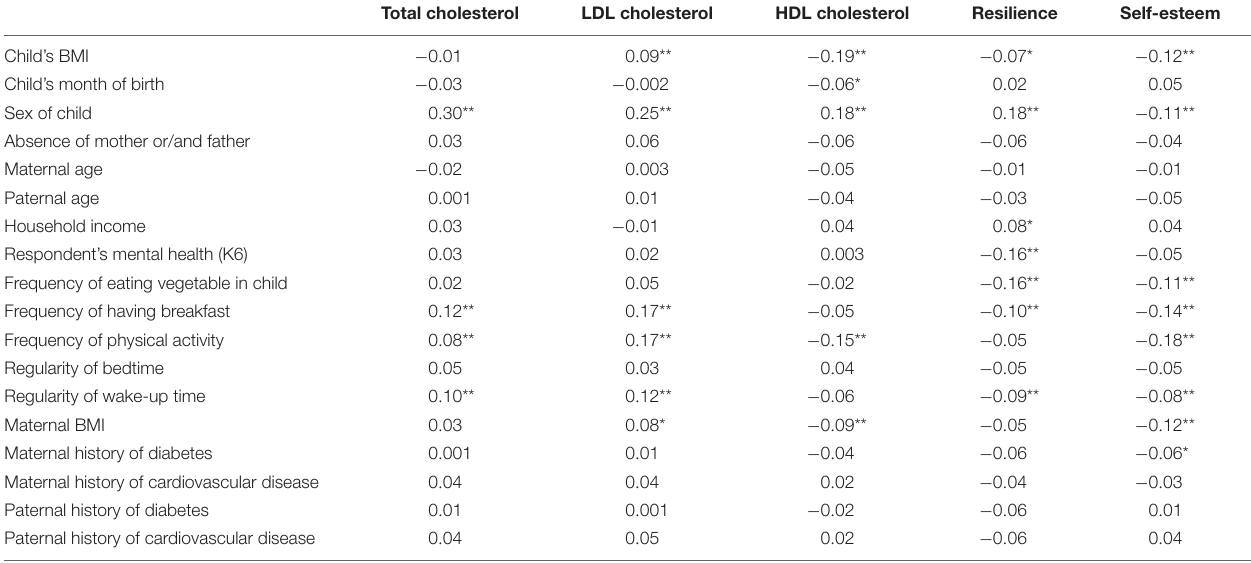
TABLE 2 | Results of Spearman’s rank correlation.